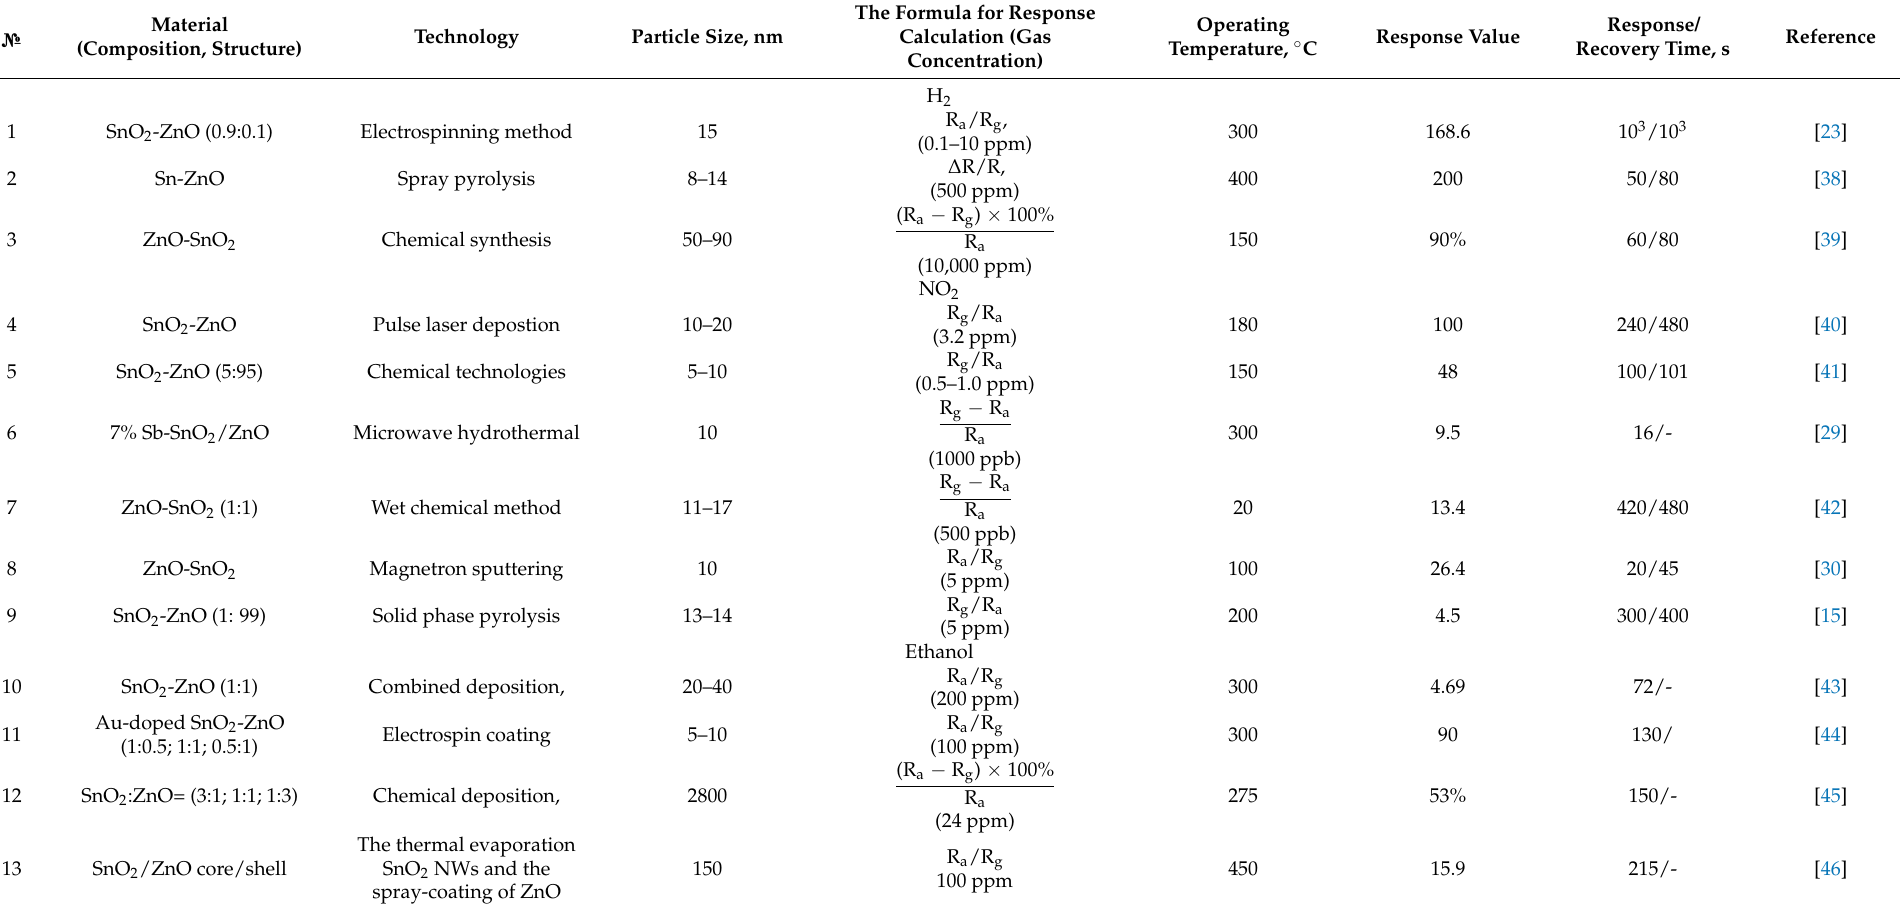
Table 1. Parameters and characteristics of gas-sensitive